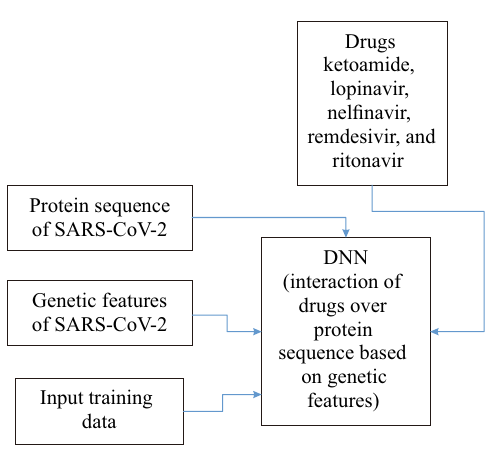
Fig. 3 Feature extraction of protein structure using artificial neural